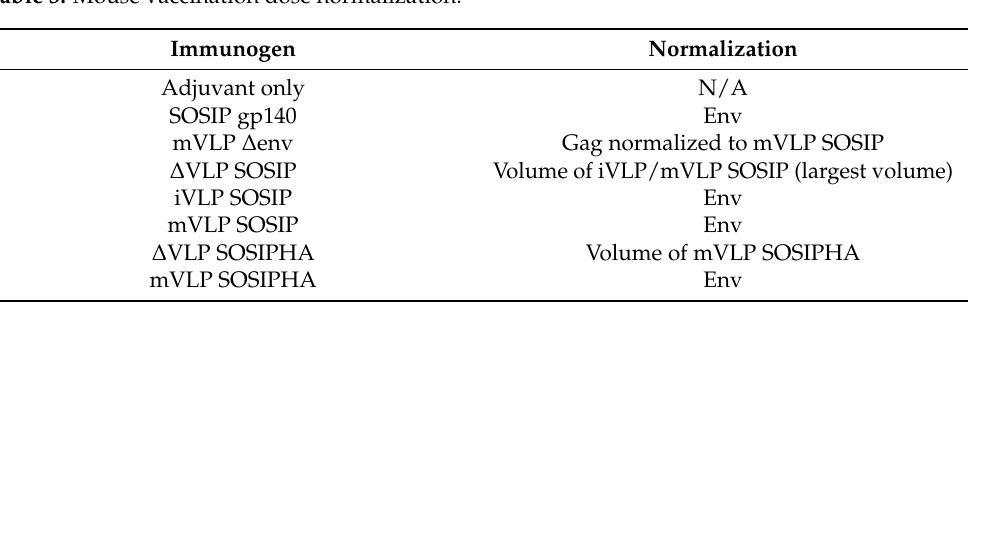
Table 3. Mouse vaccination dose